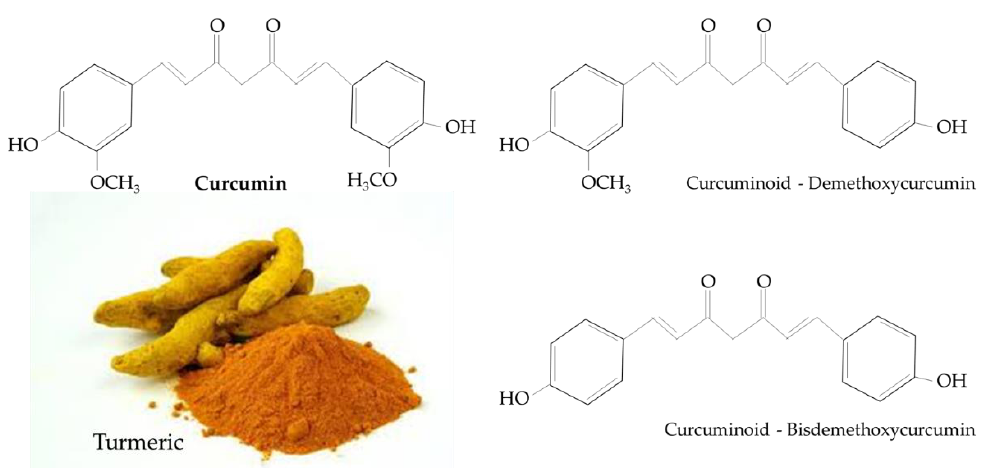
Figure 1. Chemical structure of curcumin and curcuminoids found in turmeric.